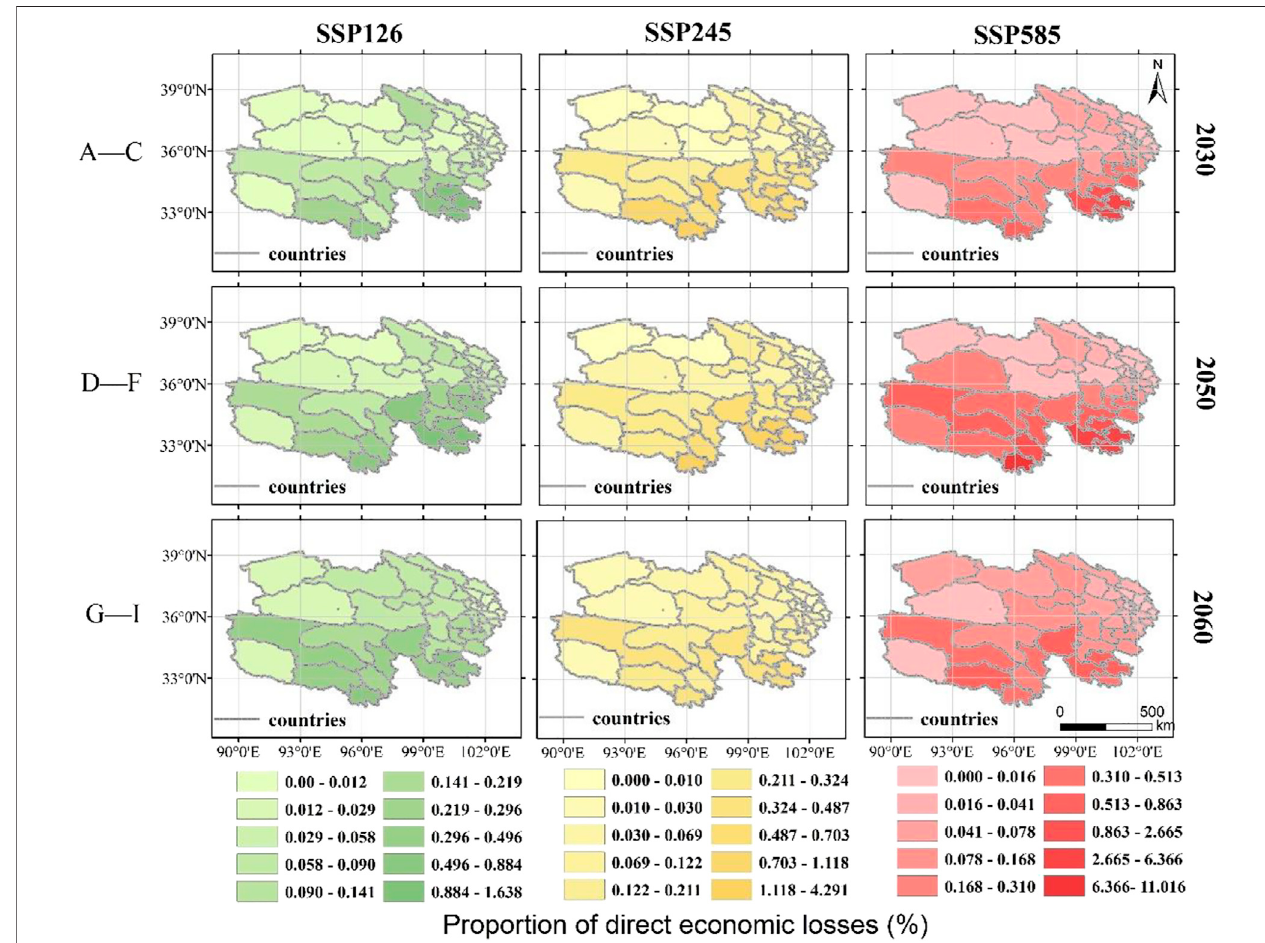
FIGURE 6 | Spatial distribution of the loss ratio in Qinghai province in 2030/2050/2060. (A – C) Countries ’ fl ood loss ratios under three scenarios in 2030; (D – F) countries ’ fl ood loss ratios under three scenarios in 2050; and (G – I) countries ’ fl ood loss ratios under three scenarios in 2060.